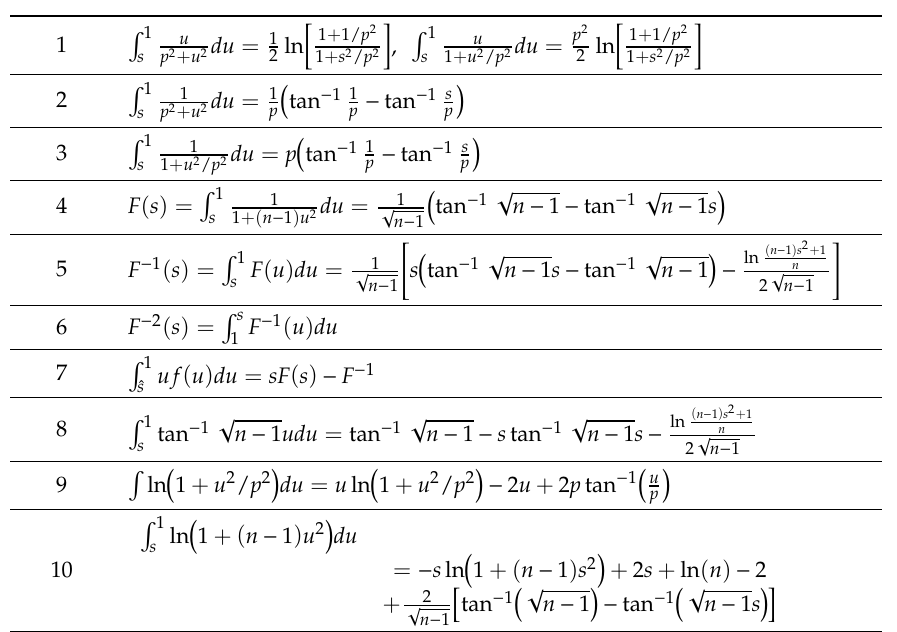
Table A1. Integral function